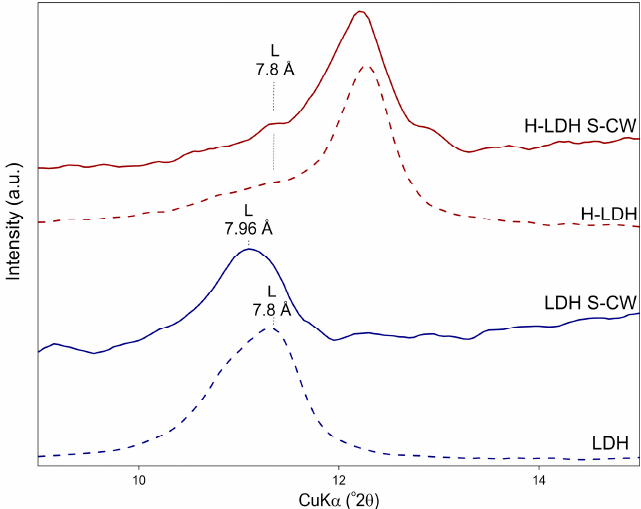
Figure 11. XRD patterns of LDH and H-LDH after reaction with S-RW (recorded in a wet state).